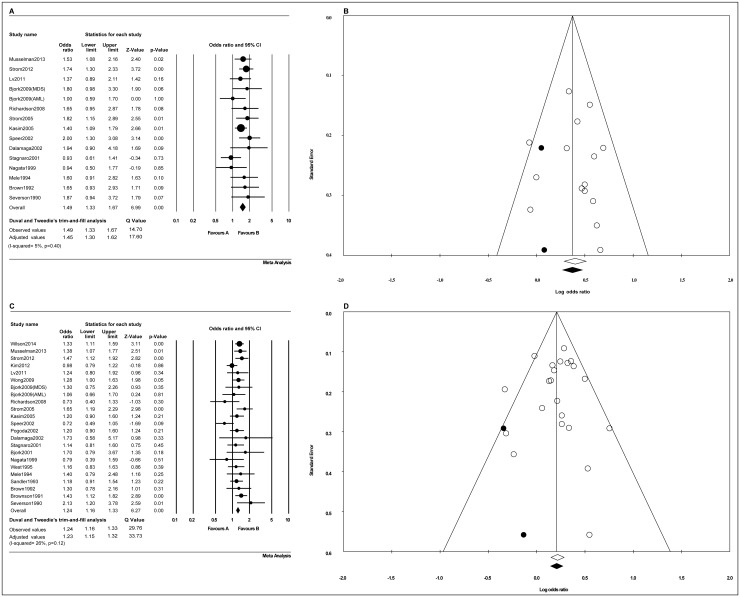
The odds ratio estimates of the risk of developing adult myeloid disease in smokers.(A) A forest plot of the risk of developing adult myeloid disease in current smokers. (B) Duval and Tweedie’s trim-and-fill funnel plots were used to observe and adjust the publication bias in current smokers. (C) A forest plot of the risk of developing adult myeloid disease in ever-smokers. (D) Duval and Tweedie’s trim-and-fill funnel plots were used to observe and adjust the publication bias in ever-smokers. Among Fig B and D, The white circles represent observed studies, and black circles represent possibly missed studies imputed using Duval and Tweedie’s trim-and-fill method. White and black rhombuses represent observed and theoretical combined effect size, respectively.